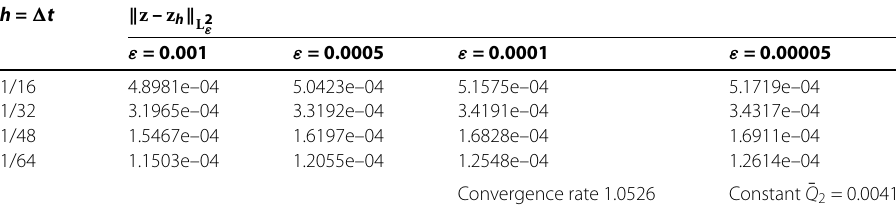
in the two-dimensional case L 2 ε